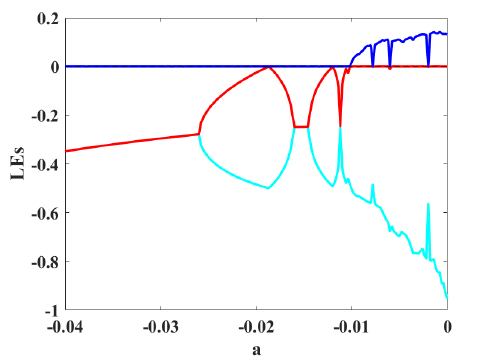
Figure 6. The diagram of LEs by changing parameter a